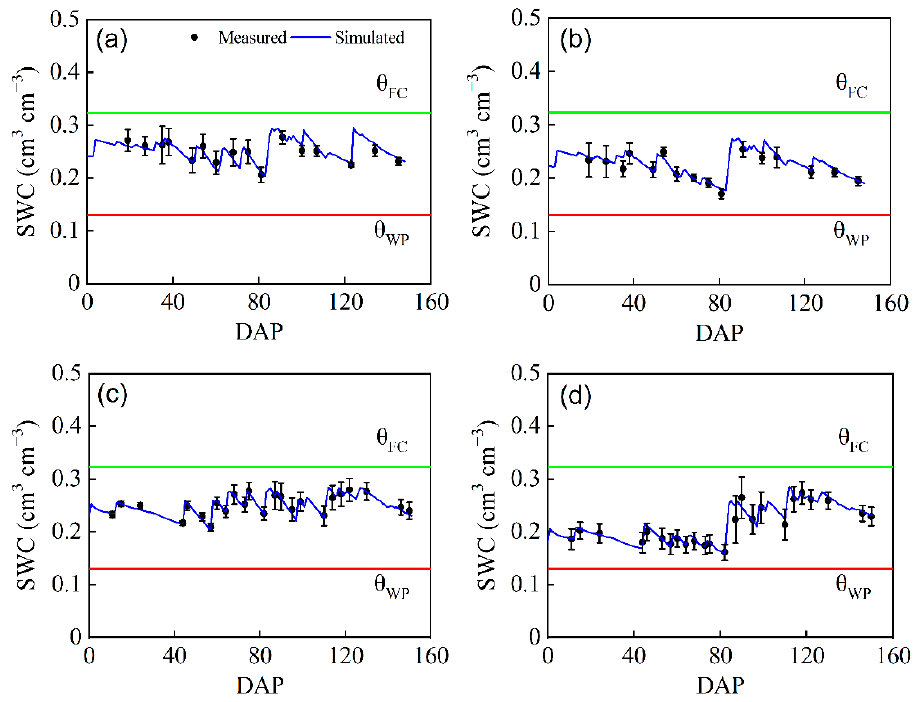
Figure 3. Measured and simulated seasonal soil water content (SWC) for two water treatments (T1 and T2) with days after planting (DAP) during the whole growth period of maize in 2017 ( a , b ) and 2018 ( c , d ).